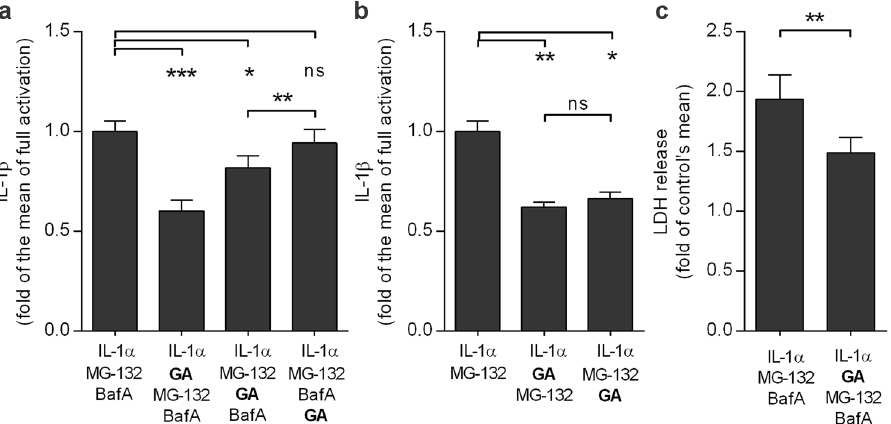
Figure 4. Geldanamycin (GA) efficiently prevents the IL-1 β release until autophagy becomes blocked ( a ). In cells exposed only to the proteasome inhibitor MG-132 GA remains effective irrespective of treatment timepoint ( b ). The reduced release of IL-1 β was not caused by increased cell death after GA addition ( c ). ARPE- 19 cells were exposed to 5 μ M MG-132 for 24 h and to 50 nM bafilomycin A1 (BafA) for another 24 h ( a ). GA (0.25 µ M) was added prior to MG-132 ( a , b ), just before BafA, or six hours after BafA ( a ) or 24 h after MG-132 ( b ). IL-1 β was measured from medium samples with the ELISA technique. The levels of LDH were measured from the cell culture medium using a commercial assay. Results are presented as mean ± SEM. * P < 0.05, ** P < 0.01, *** P < 0.001, ns = not significant, Mann –Whitney U